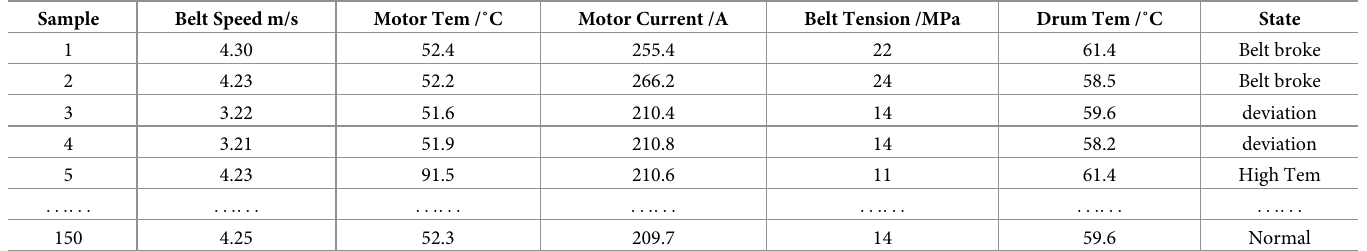
Table 1. Partial data